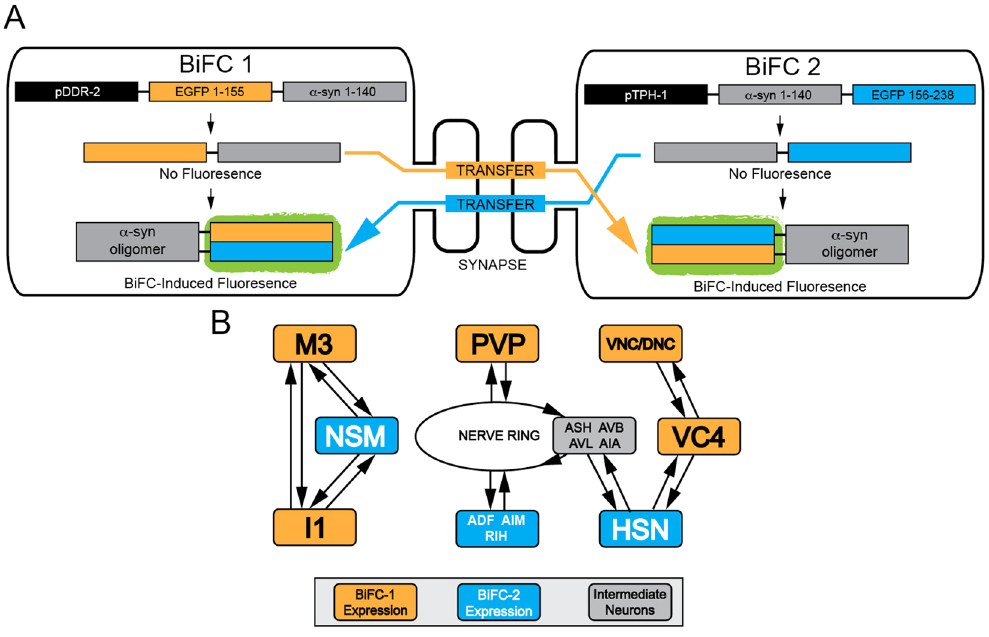
Figure 1. Using BiFC-induced fluorescence to monitor neuron-to-neuron transfer of a-synuclein. ( A ) Model of BiFC-induced fluorescence following transfer of BiFC1 molecules (full-length WT α -syn tagged with N-terminus EGFP) expressed in cells under the control of the ddr-2 promoter to cells expressing BiFC2 molecules (full-length WT α -syn tagged with C-terminus EGFP) under the control of the tph-1 promoter, and vice-versa. BiFC1 and BiFC2 molecules combine following α -syn transfer and dimerization resulting in the fluorescence of the now functional EGFP molecule. ( B ) Schematic of some of the neurons involved in cell-to- cell transfer of BiFC-tagged α -syn in our model. Boxes represent BiFC-1-expressing neurons (orange), BiFC-2- expressing neurons (blue) or several non-BiFC expressing intermediate neurons (grey). VNC = Ventral Nerve Cord, DNC = Dorsal Nerve